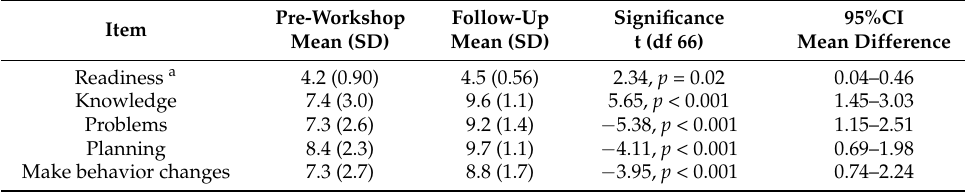
Table 2. Changes to HEW’s use of Behavior Change Techniques